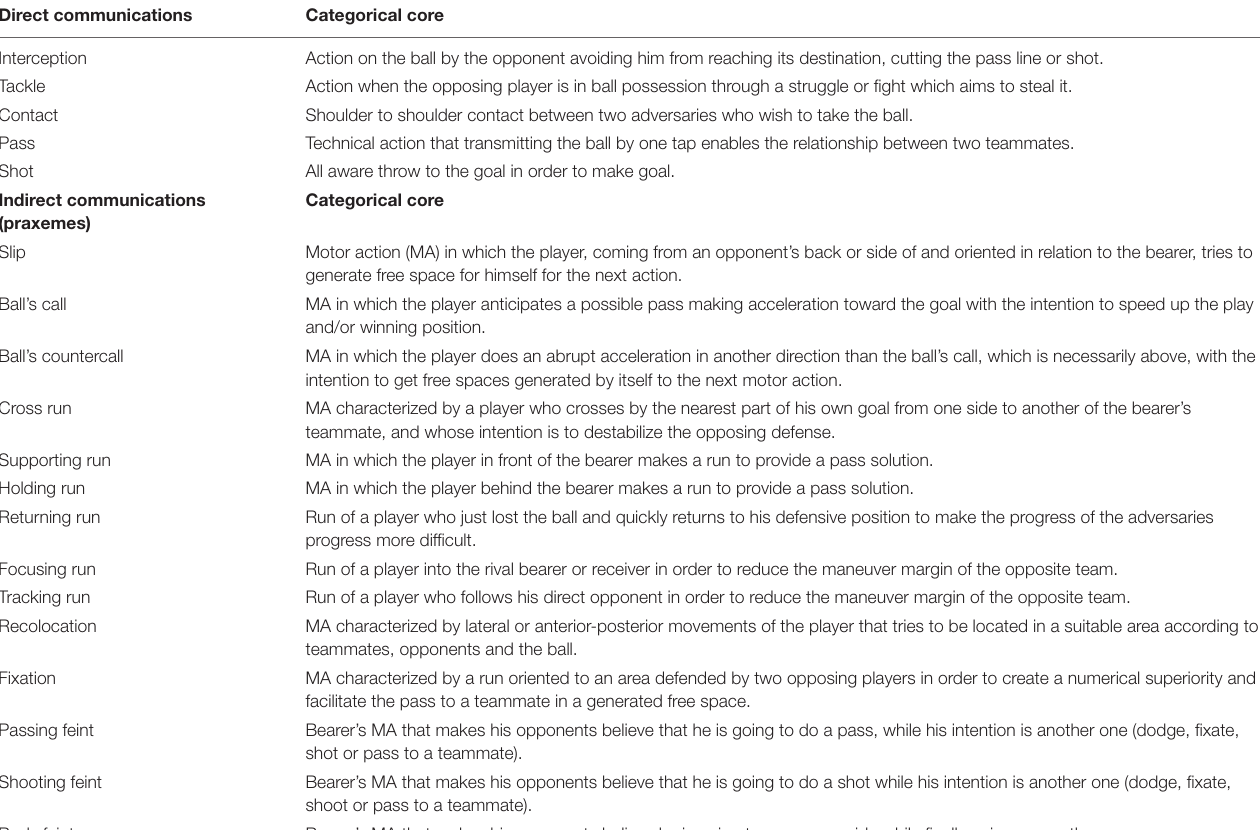
TABLE 1 | The 19 praxical communications (5 direct communications and 14 praxemes) of football associated with their tactical description. Direct communications Categorical core